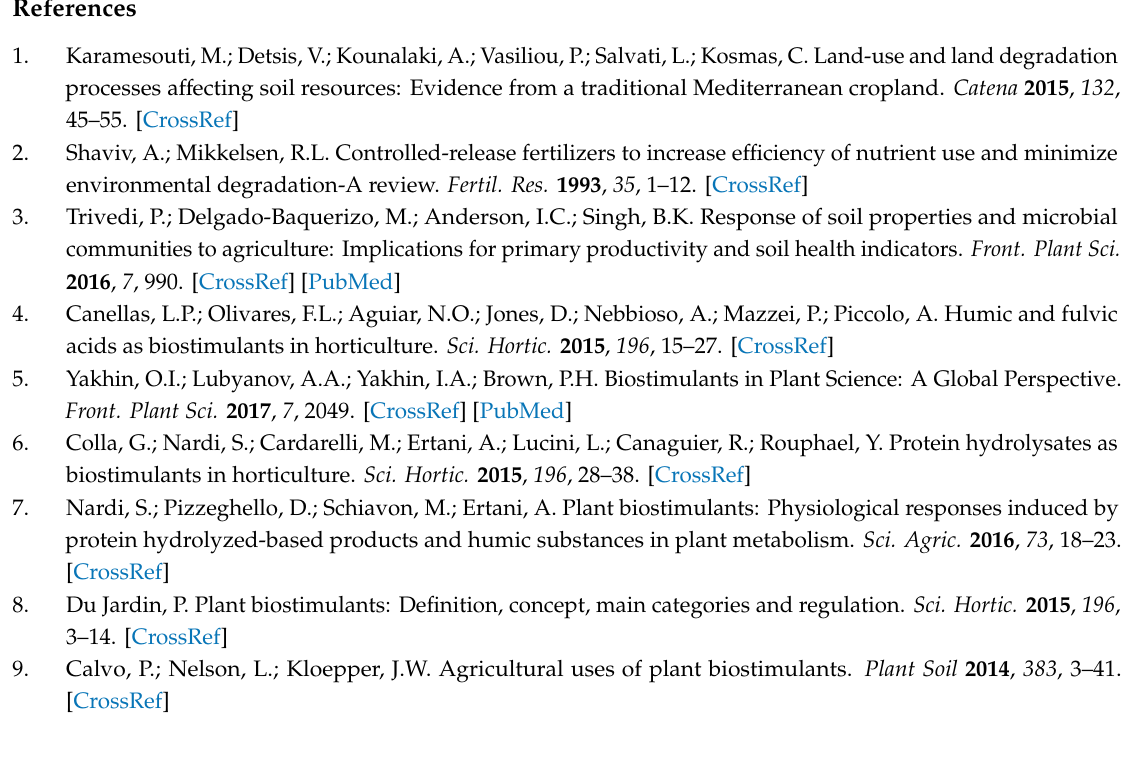
Table S1: Correlations between variables determined using Pearson’s coe ffi cient. Asterisks indicate significant correlation at p < 0.05 (*) or p < 0.01 (**). r = root, l = leaf, dw = dry weight, TP = total phenols, GS = glutamine synthetase, GOGAT = glutamate synthase, FRU = fructose, GLU = glucose, PROT = proteins, Table S2: Loadings values of the plant variables on the axes identified by principal components (PC) analysis for the di ff erent types of treatment and control. r = root, l = leaf, dw = dry weight, TP = total phenols, GS = glutamine synthetase, GOGAT = glutamate synthase, FRU = fructose, GLU = glucose, PROT = proteins. Figure S1: Position of the treated and untreated plants (1 = LS1, 2 = LS2, 3 = LS3, 4 = LS4, 5 = LS5, 6 = PH, 7 = LH, and 8 = control) in the reduced space of the first two principal components (PC1 and PC2) (A) and on PC1 and PC3 (B); variables projected in the plane determined by PC1 and PC2 (D) and PC1 and PC3 (C). r = root, l = leaf, dw = dry weight, TP = total phenols, GS = glutamine synthetase, GOGAT = glutamate synthase, FRU = fructose, GLU = glucose, PROT = proteins, Figure S2: Heat map of plant-associated parameters influenced by individual humates. Di ff erent colors indicate di ff erent levels of induction / repression (more red more repression, more blue more induction). r = root, l = leaf, dw = dry weight, TP = total phenols, GS = glutamine synthetase, GOGAT = glutamate synthase, FRU = fructose, GLU = glucose, PROT =